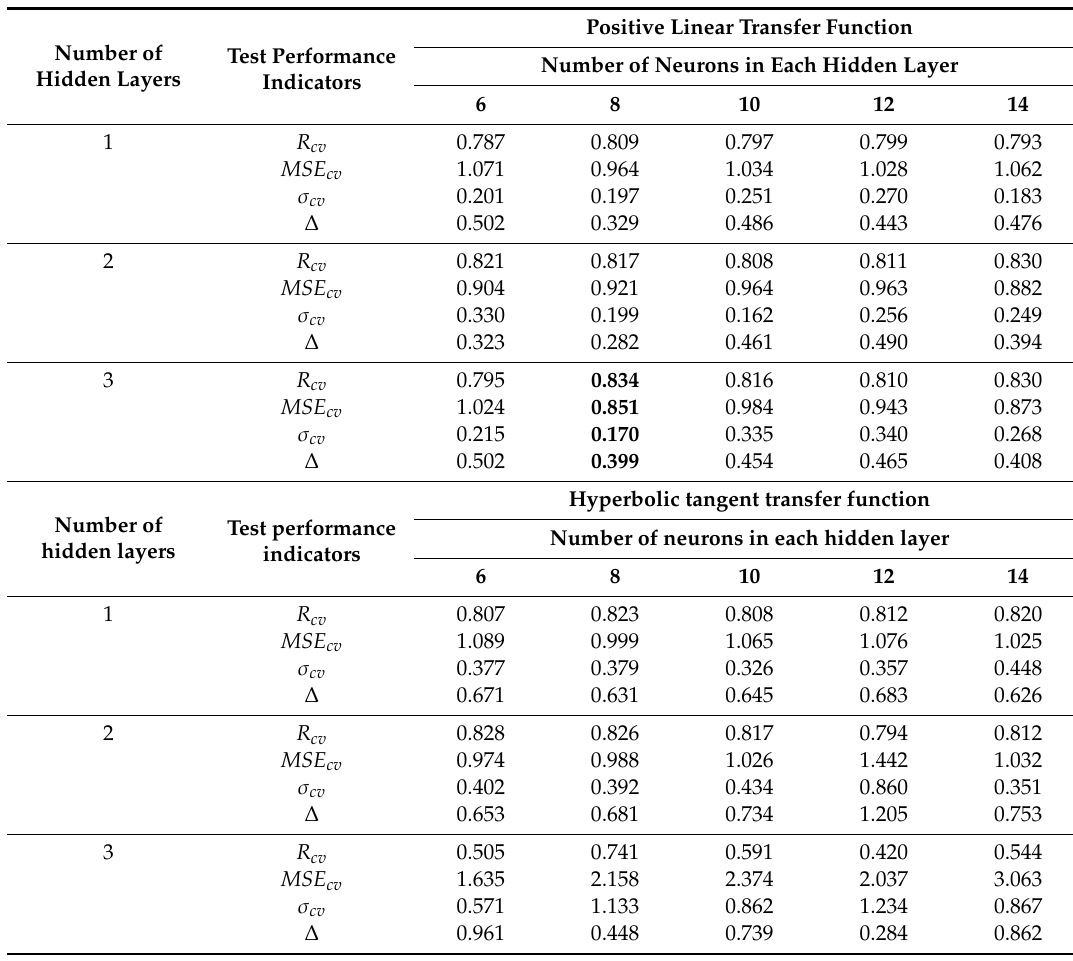
Table 5. Estimates of Marshall stability models’ predictive performance by five-fold cross